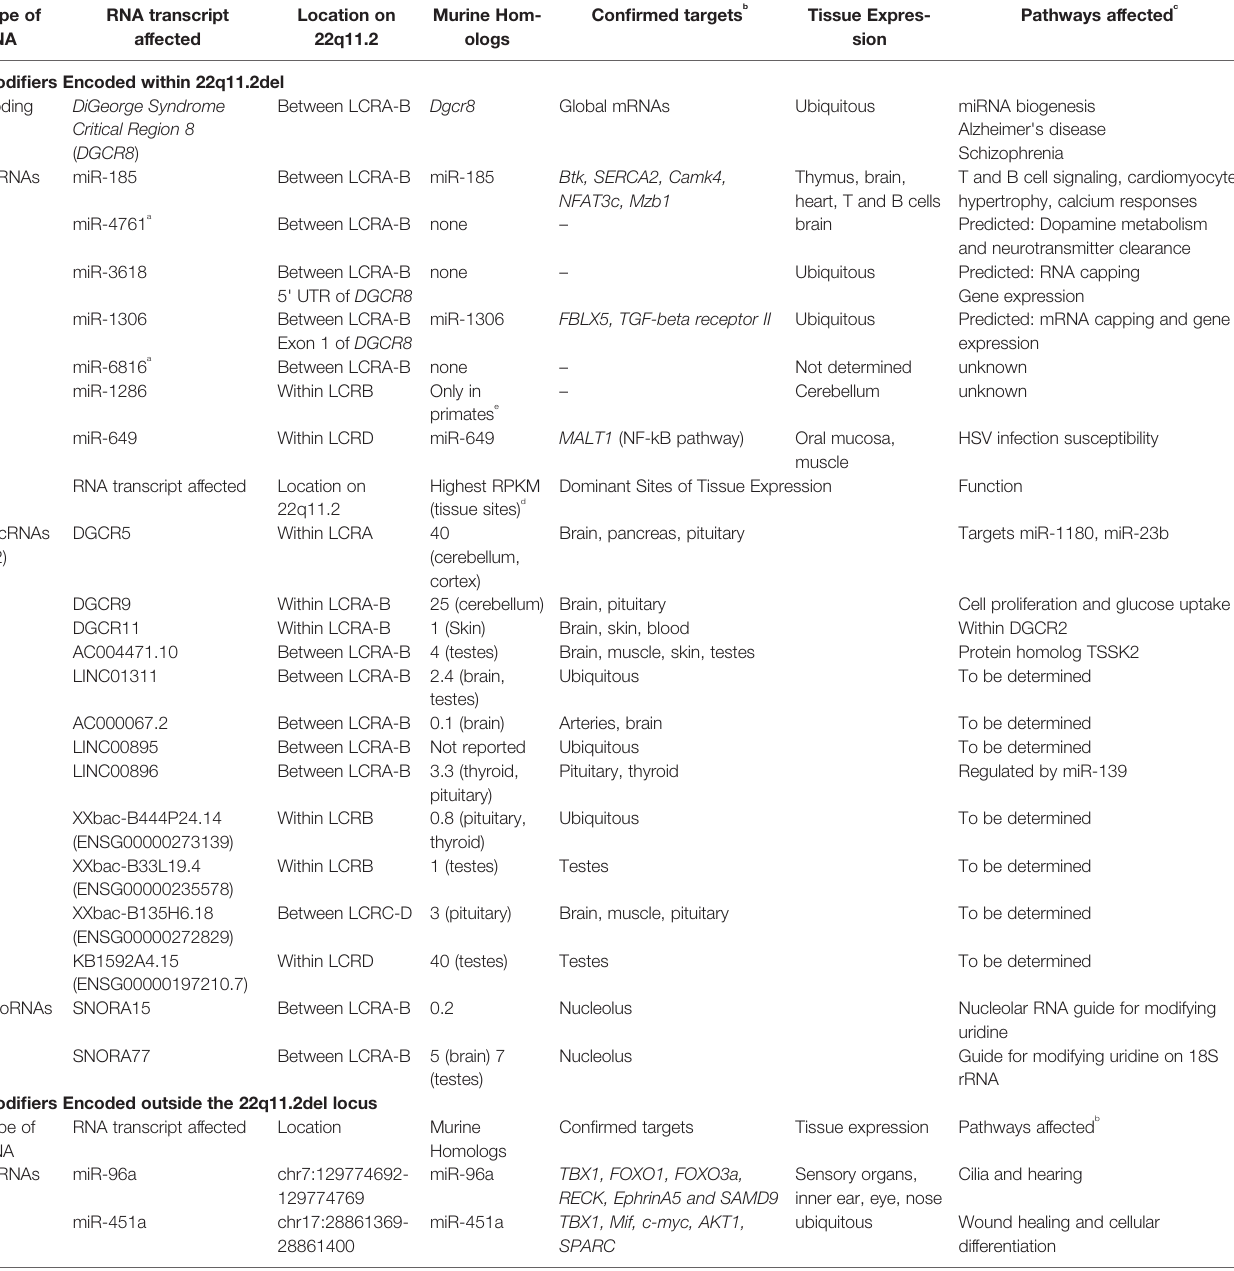
TABLE 2 | Epigenetic modi fi ers of 22q11.2 locus: Noncoding RNA regulators and noncoding RNAs. Type of